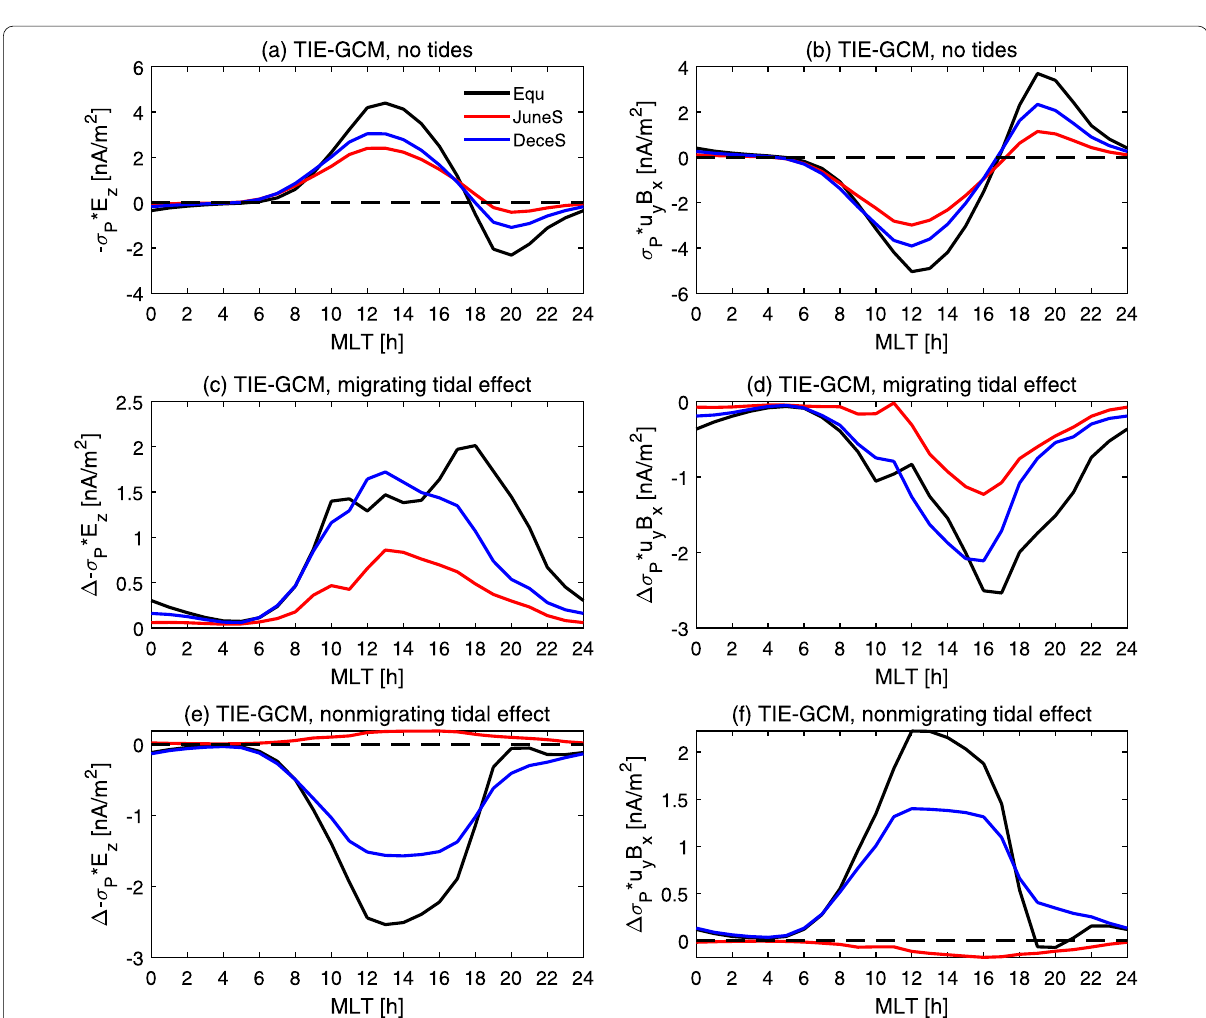
Fig. 5 Local time distribution of the polarization current (left) and dynamo current (right). a , b IRC without tides; c , d migrating tidal effect; e , f nonmigrating tidal effect. Black, red, and blue curves denote the equinox, JS, and DS, respectively. Positive values represent outward